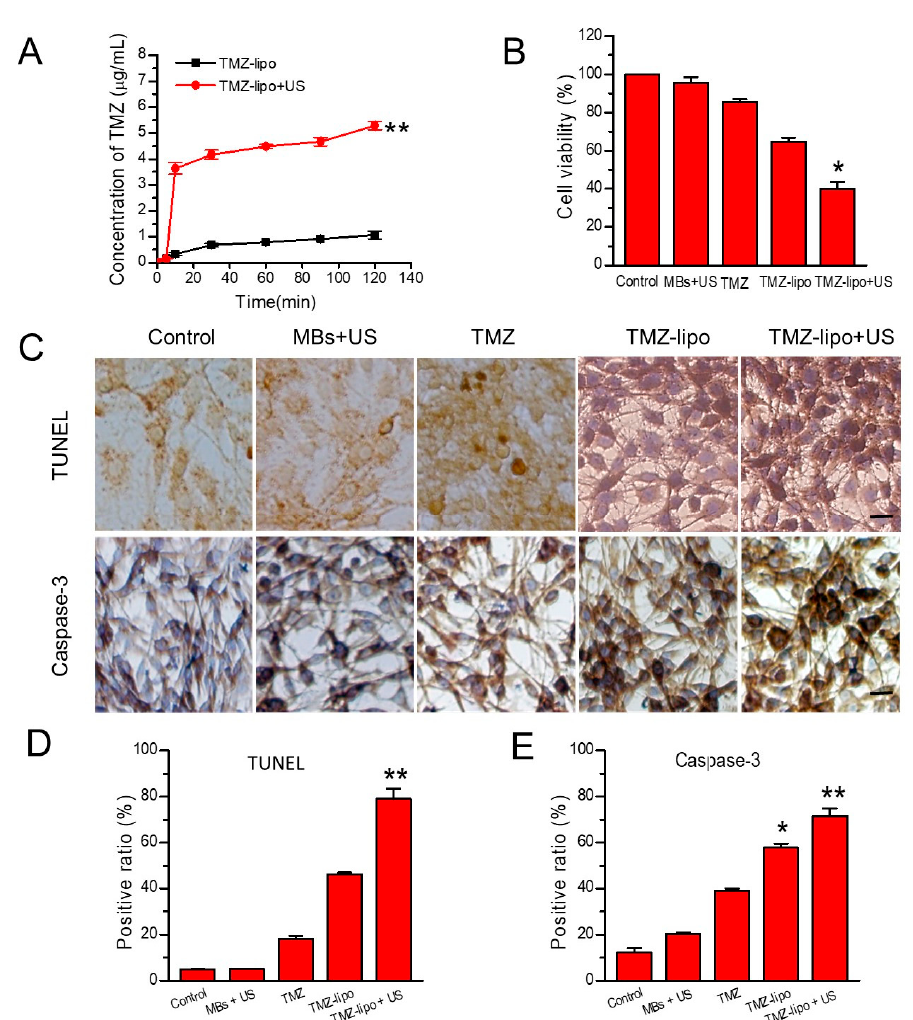
Figure 4. Cytotoxic effects of TMZ-lipo on C6 cells in the BBB model. ( A ) TMZ concentrations across the in vitro BBB model treated with TMZ-lipo, or TMZ-lipo + US. ( B ) Viability of cells treated with MB, TMZ, TMZ-lipo, or TMZ-lipo + US. ( C ) Representative images of TUNEL and immunohisto- chemical staining after treatment in the in vitro BBB model. Scale bar = 10 μ m; * p < 0.05, ** p < 0.01. ( D ) Percentage of TUNEL-positive cells. ( E ) Percentage of caspase-3-positive cells.